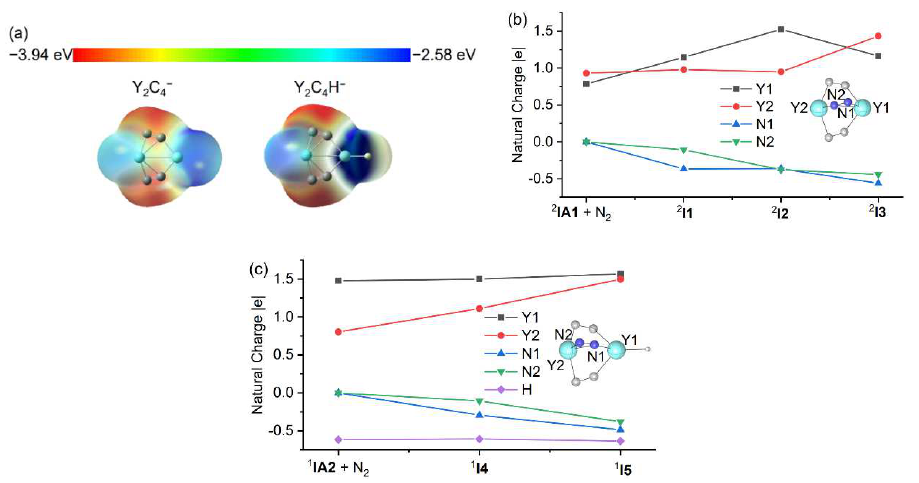
Figure 4. ( a ) Electrostatic potentials of the Y 2 C 4 H 0,1 − . Charges on atoms of stationary points along reaction coordinates of N 2 absorption on ( b ) Y 2 C 4 − and ( c ) Y 2 C 4 H − clusters.